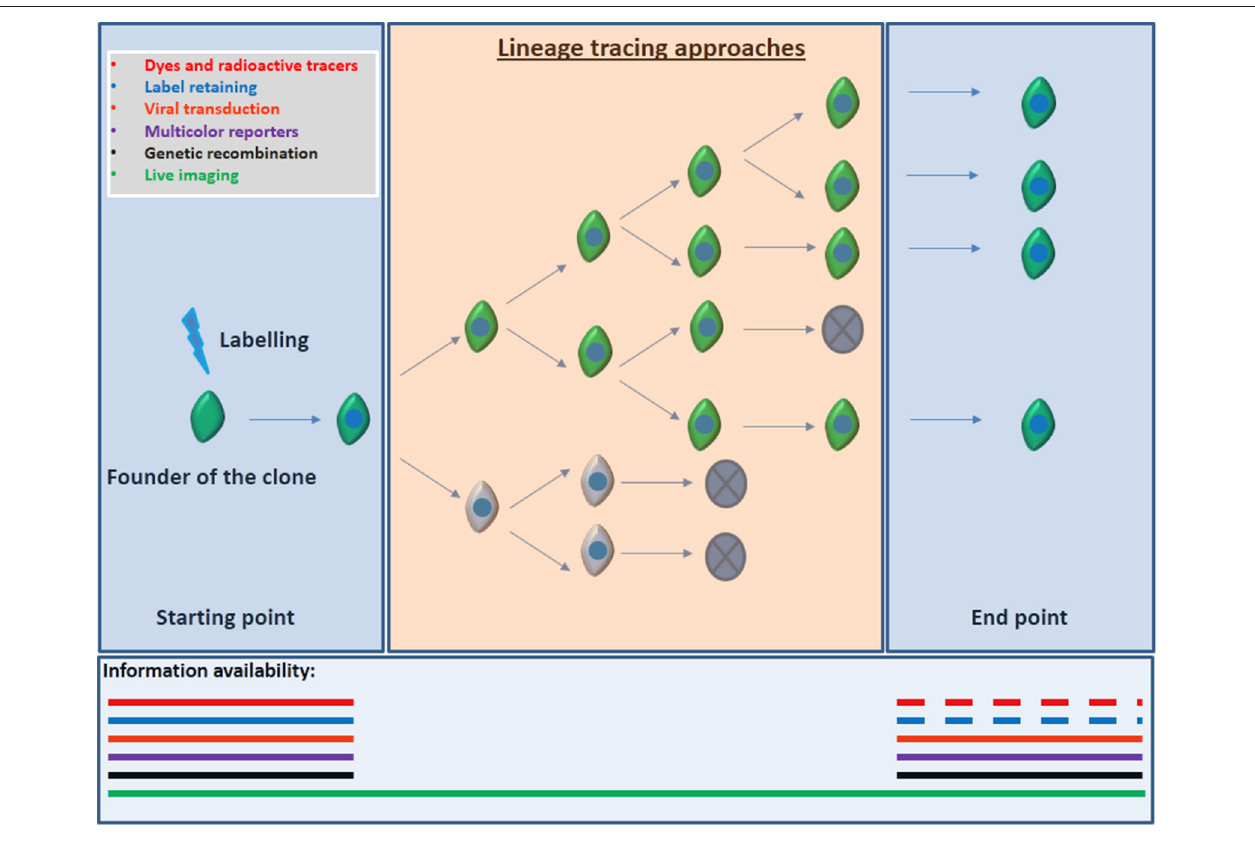
FIGURE 2 | Information available according to the lineage tracing approach employed. Most of the lineage tracers implies a readout based on static end-point experiments. That implies that information regarding cell death, proliferation, differentiation, cell fate decisions, and migration inside or outside of the field of view of cell populations might be missing. Discontinuous segments of lines depict the lack of information that may also occur when using dyes or label retaining due to the dilution of the signal after several rounds of proliferation. Conversely, direct observation by live imaging allows for the visualization of each event from the founder of the clone, till the clone is formed improving the strength of the conclusions obtained from the